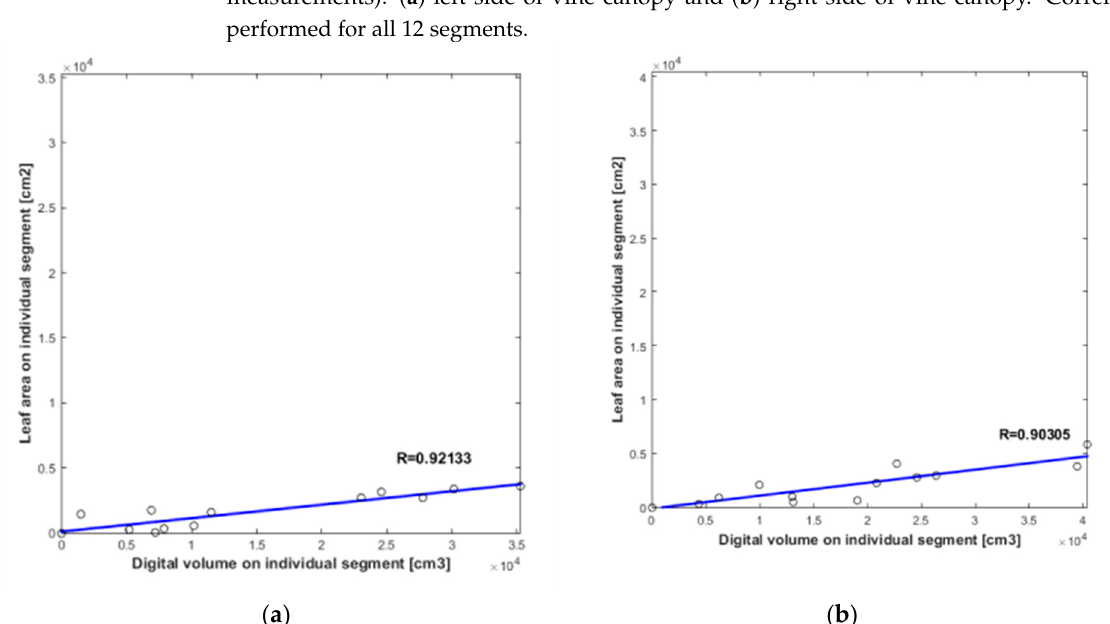
Figure 15. Correlation between vine canopy volume (photogrammetric measurements) and leaf area (manual measurements): ( a ) left side of vine canopy and ( b ) right side of vine canopy. Correlation was performed for all 12 segments.